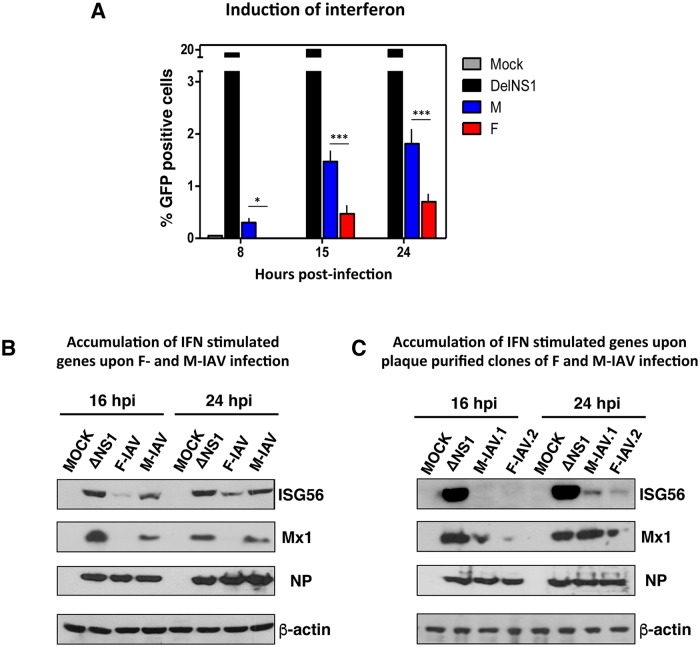
Different induction levels of antiviral response in F- or M-IAV infected cells.(A) Induction of GFP expression after infection of A549/pr(IFN- β) at moi 3.GFP cells were quantified by FACS, using ΔNS1 virus as reference and percentage of GFP positive cells is represented. The results shown are representative of 3 independent experiments, in which 10,000 events were measured for each sample. Significance was determined by two-way ANOVA with Bonferroni post hoc test, *p<0.05; ***p<0.001. (B) Cultured human lung epithelial cells (A549) were infected at moi 3 with F- and M-IAV stocks or (C) with plaque purified clones of F- or M-IAV. At indicated hours post-infection (hpi), samples were used to detect the indicated proteins by Western blot. MOCK, cells treated with PBS as negative control; ΔNS1, cells infected with influenza virus lacking NS1 protein as a positive control of innate immune response activation after influenza virus infection. Virus infection was detected with antibody specific for NP, using β-actin as loading control. The experiments B and C were performed in triplicates and one representative data are shown. Quantification and significance analysis of triplicates is shown in S4 Fig.